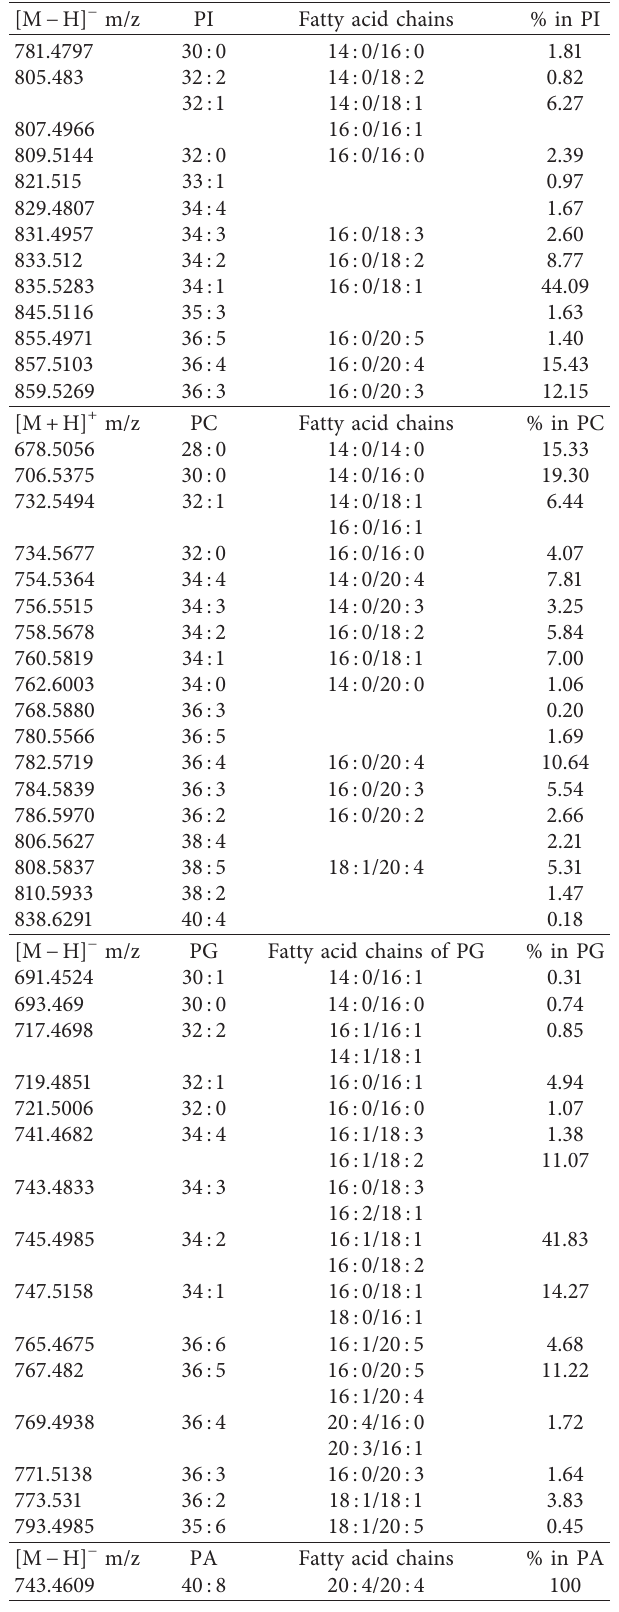
Table 3: Molecular species of phospholipid including PI, PC, PG, and PA groups identified by HPLC-HRMS as negative [M − H] − ion and positive [M +H] + ion, and identification as phospholipid and fatty acyl composition confirmed by the analysis of the LC-MS/ MS spectra of each